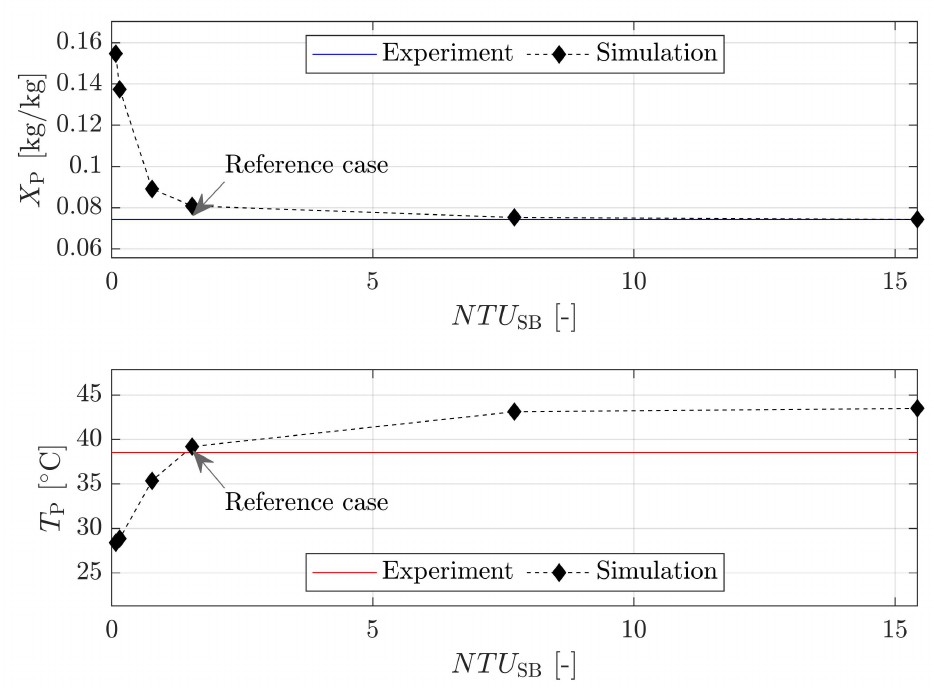
Figure 19. Sensitivity analysis of model predictions regarding the number of transfer units between suspension and bubble phase. The impact on particle moisture content ( X P ) (top) and particle temperature ( T P ) (bottom) for reference case GF3_C_02 with Cellets particles in the GF3 lab-scale dryer is